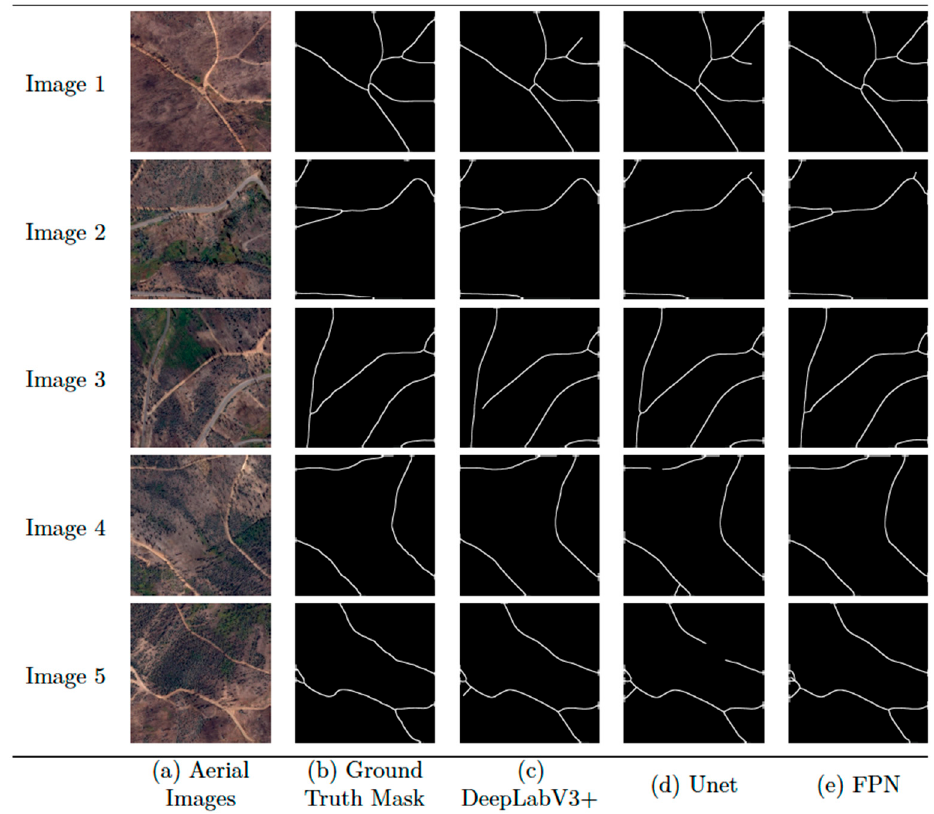
Figure 11. Rural road extraction network for the Mação district using the Zhang–Suen thinning al- gorithm – a comparison between multiple roads detected with different road detection algorithms studied.